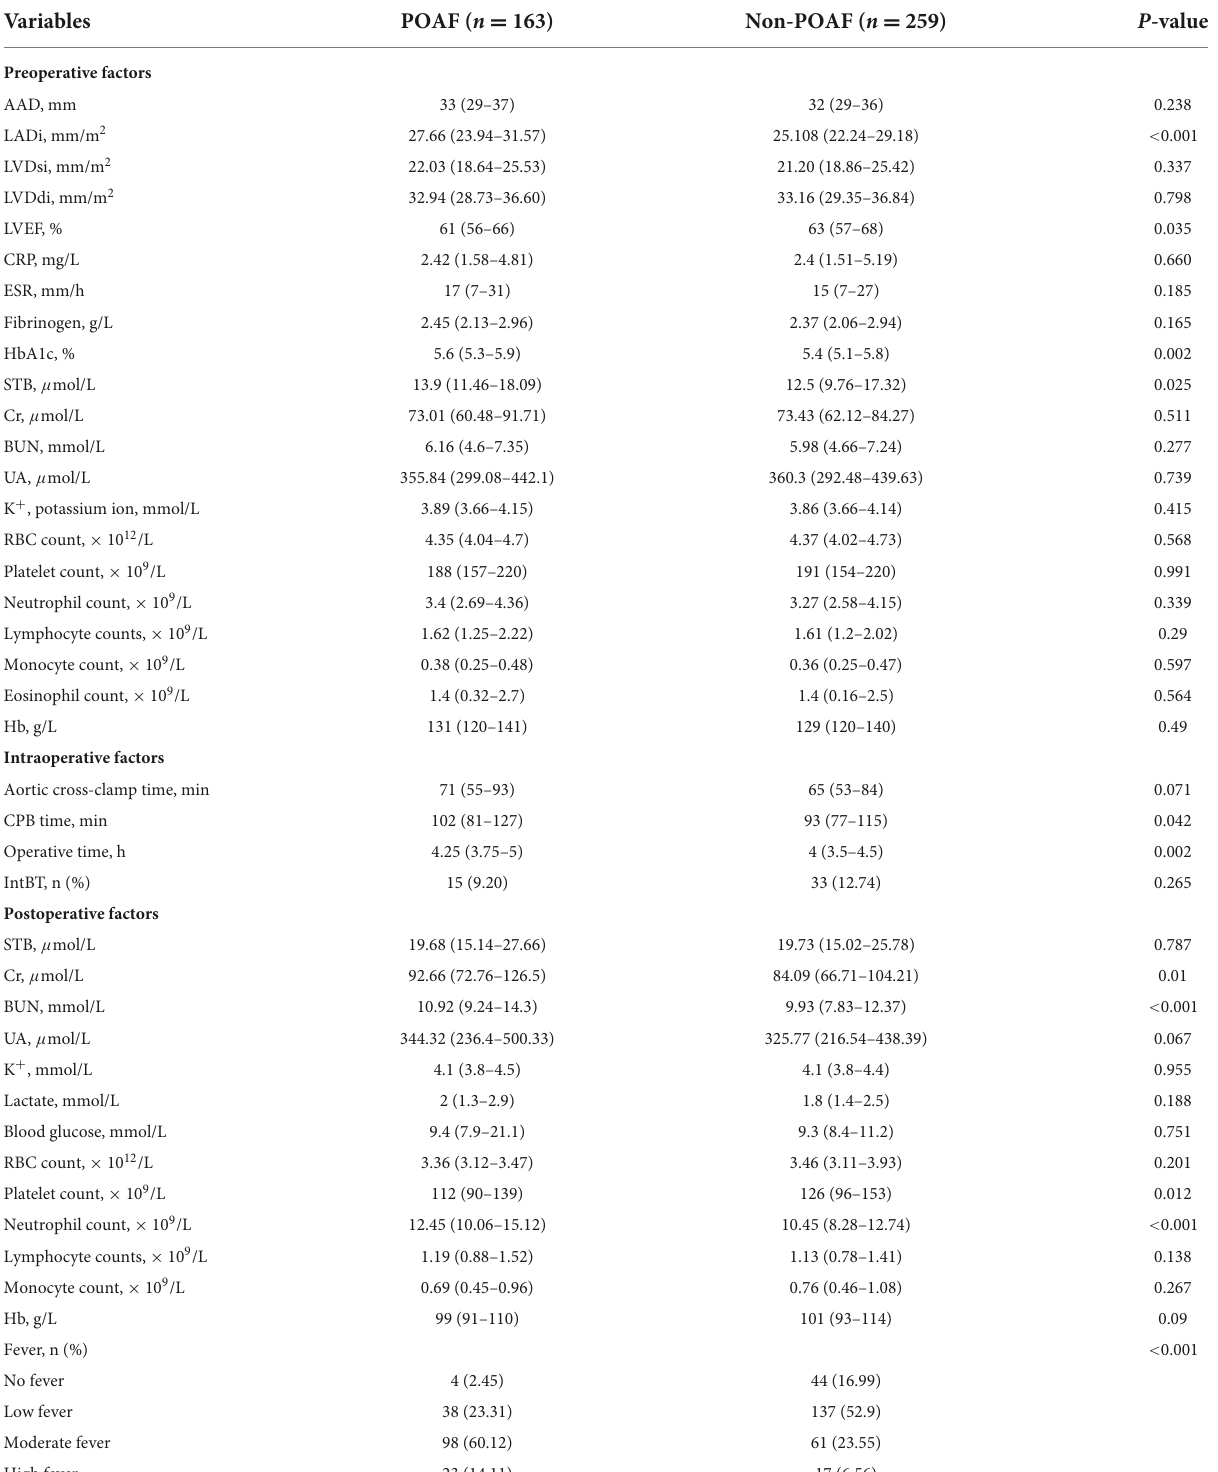
TABLE 2 Perioperative factors of patients with or without